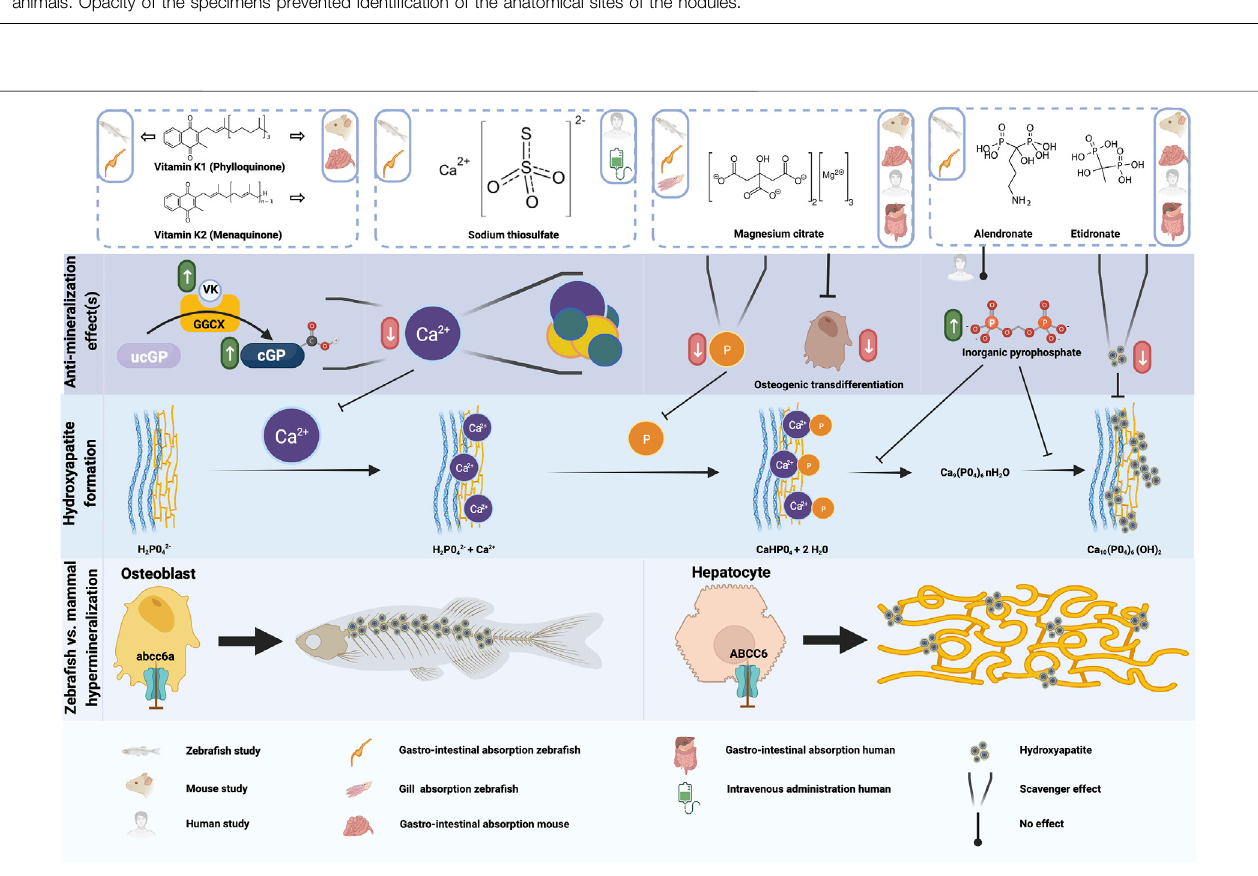
FIGURE 4 | Schematic representation of the anti-mineralization effects of the tested compounds. For the compounds evaluated in the present study, the type of administrationorabsorptionismentionedinthetoprow,aswellasthetypeofadministrationusedinanymouseorhumanstudieswhichweredonewiththiscompound. The anti mineralizing effects of the different compounds are shown, as well as where these effect take place in the cascade to form hydroxyapatite crystals. Finally, the differences between the hypermineralization in zebra fi sh and mammals with respect to abcc6a and ABCC6 de fi ciency are shown. Figure created with BioRender.com.